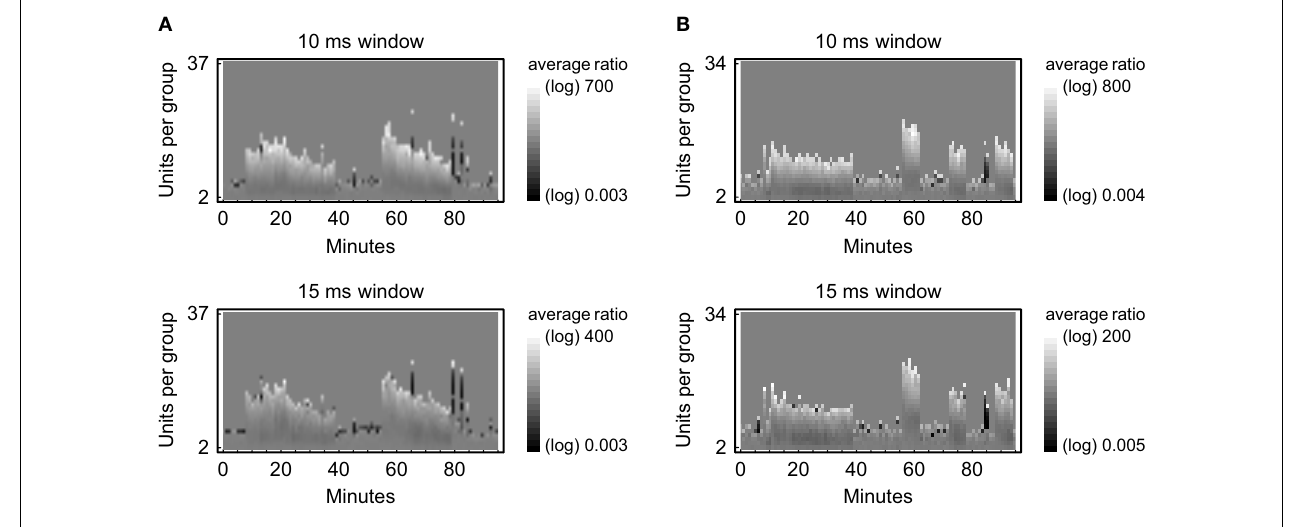
FIGURE 4 | Relative frequencies of joint-spike events depending on time and complexity. A sliding window was moved from spike to spike to collect groups of coincident spikes (joint-spike events) in parallel recordings of neuronal activity from rat visual cortex in vitro .Their frequency of occurrence is compared against the corresponding values from 100 surrogate data sets that have been obtained by randomly shifting the original spike trains by an average amount of 5–7ms. Relative frequencies are expressed on a